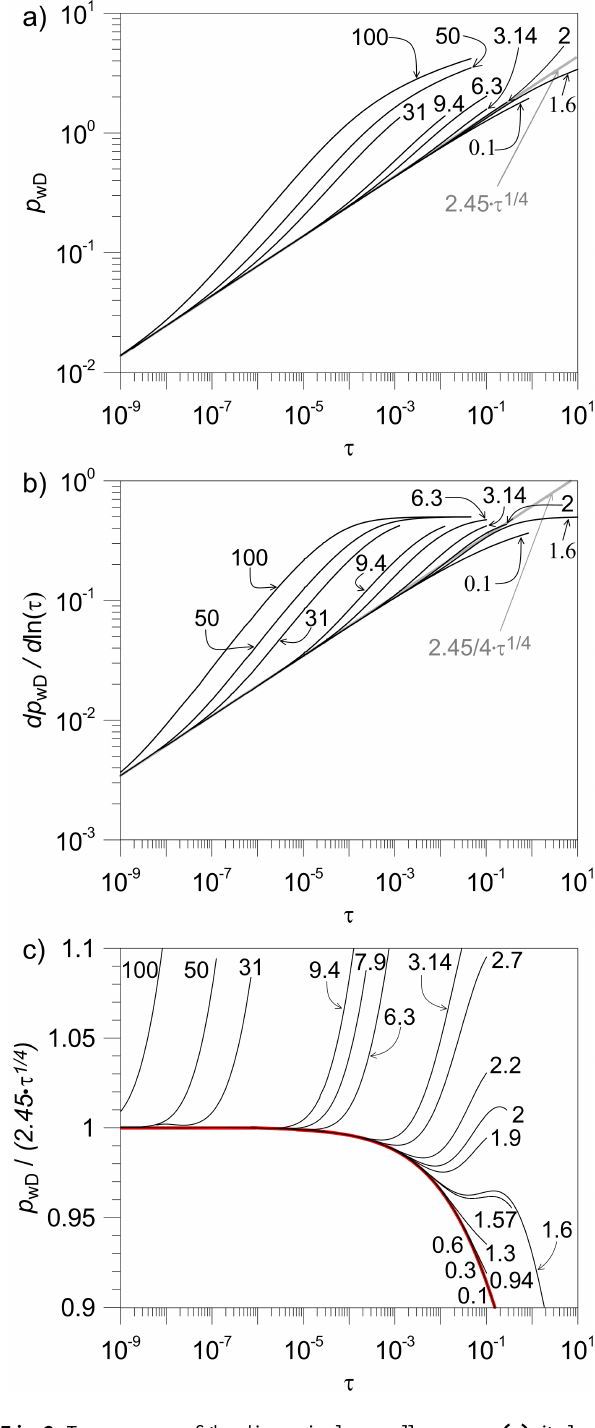
Fig. 2. Type curves of the dimensionless well pressure (a) , its log- arithmic derivative (b) , and of the normalized well pressure (c) as functions of dimensionless time. Note that (c) is actually a restricted zoom of the data presented in (a) and (b) . For example, the clock- wise bending of the curve for T D = 100 prominent in (a) is out- side of the chosen scale. The red line in (c) represents the normal- / 2 . 45 τ 1 / 4 , where p ∞ ized curve p ∞ is the master curve for an wD wD infinitely long fracture (see Table